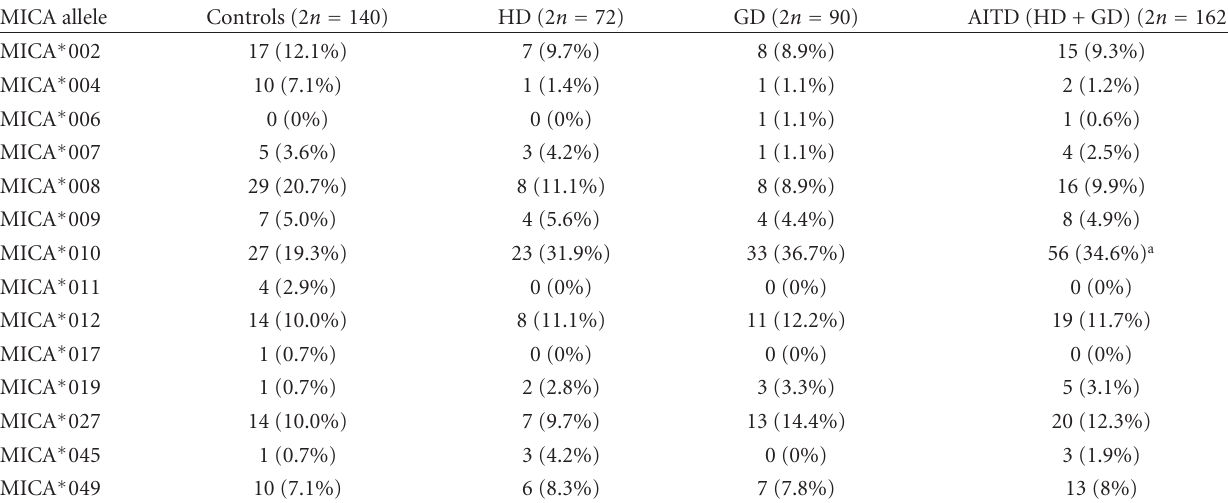
Table 1: MICA allele frequencies in patients with AITD and